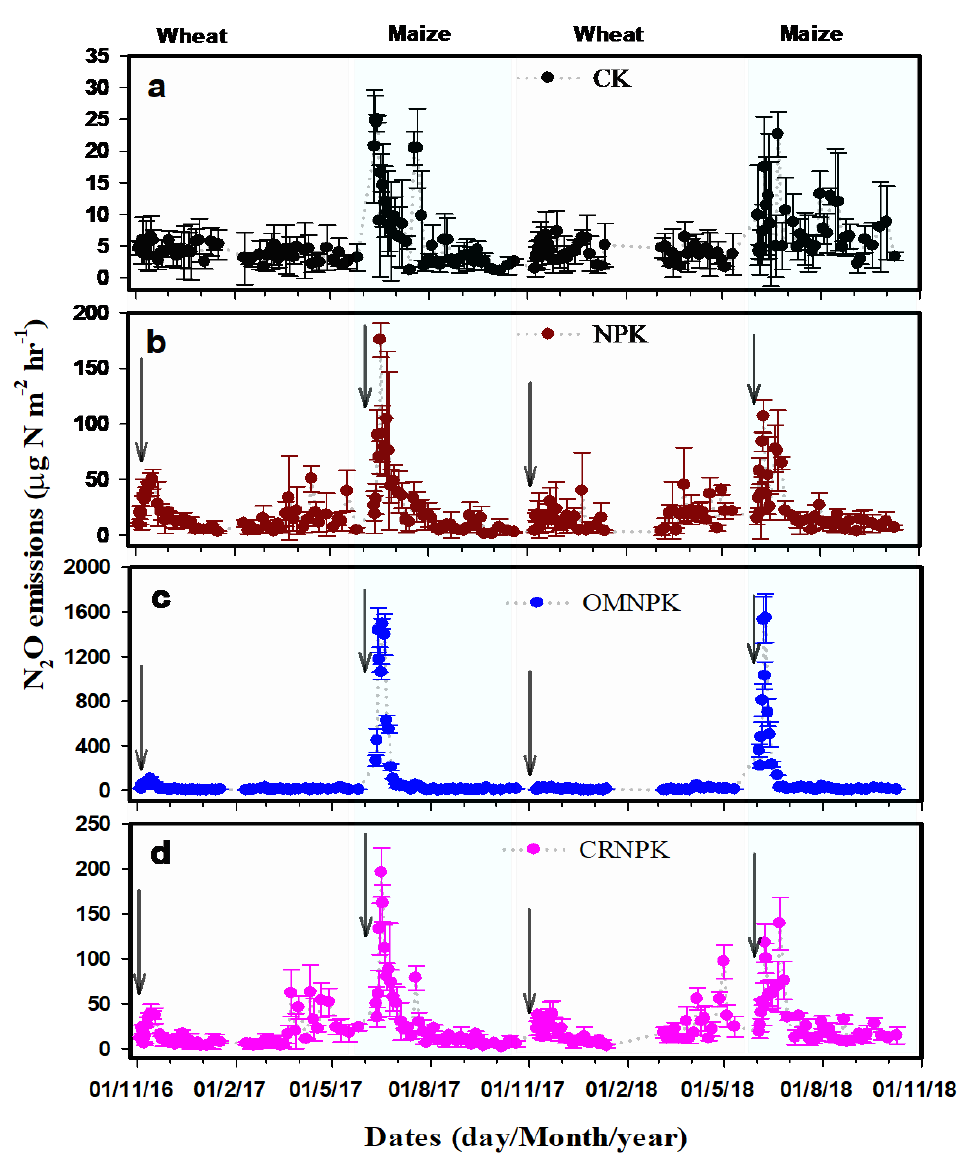
Figure 4. Seasonal variations in N 2 O emissions in the wheat-maize rotations for CK = control ( a ), NPK = mineral fertilizers ( b ), OMNPK = pig manure combined with mineral fertilizers ( c ) and CRNPK = crop residue combined with mineral fertilizers ( d ) treatments over the two-year period from 2016 – 2018. The vertical bars in the panels indicate the standard errors of spatial replicates ( n = 3). The downward arrows indicate the date of different amendment applications.